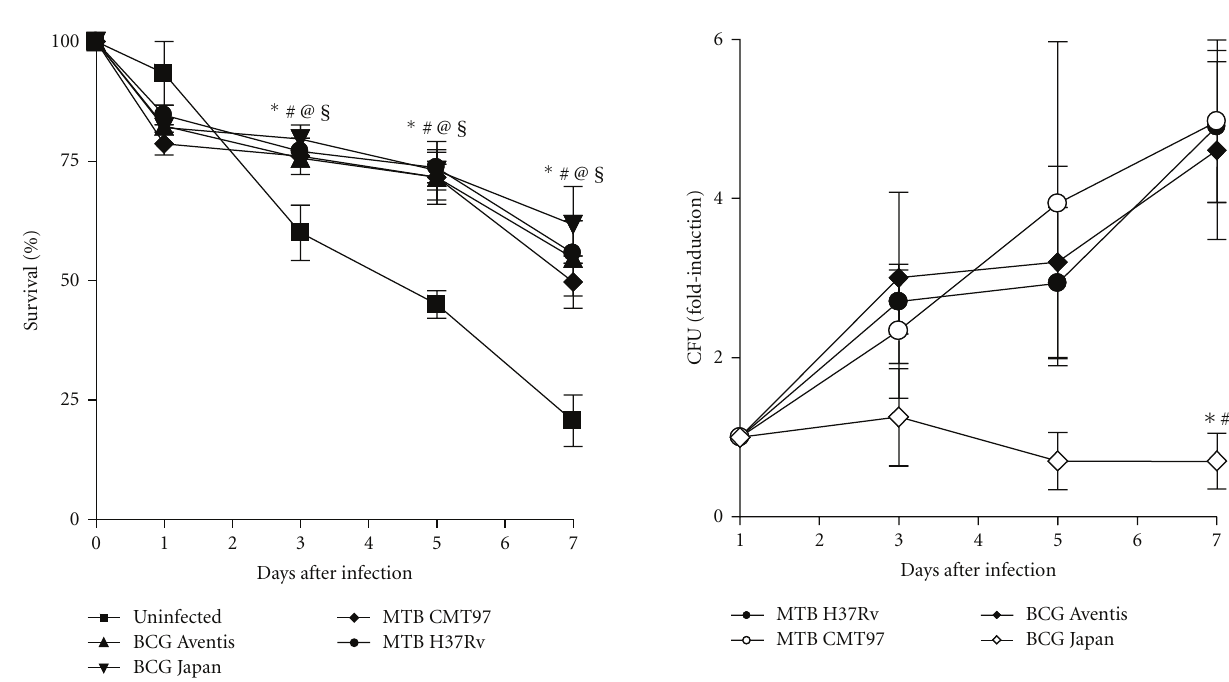
Figure 2: Cell recovery of DCs following infection with di ff erent mycobacterial strains. DCs infected or uninfected were enumerated by trypan blue at the indicated time points. Time 0 is referred to DCs before infection; following time points indicate days after infection. Data are shown as mean ± SEM from 3 independent experiments. Statistical significance was assessed by using two-way ANOVA. (Significant di ff erences at 3 days after infection: ∗ MTB H37Rv versus uninfected, P < . 05; # MTB CMT97 versus uninfected, P < . 05; @ BCG Aventis versus uninfected, P < . 05; § BCG Aventis versus uninfected, P < . 05. significant di ff erences at 5 and 7 days after infection: ∗ P < . 001; # P < . 001; @ P < . 001; § P < . 001.)